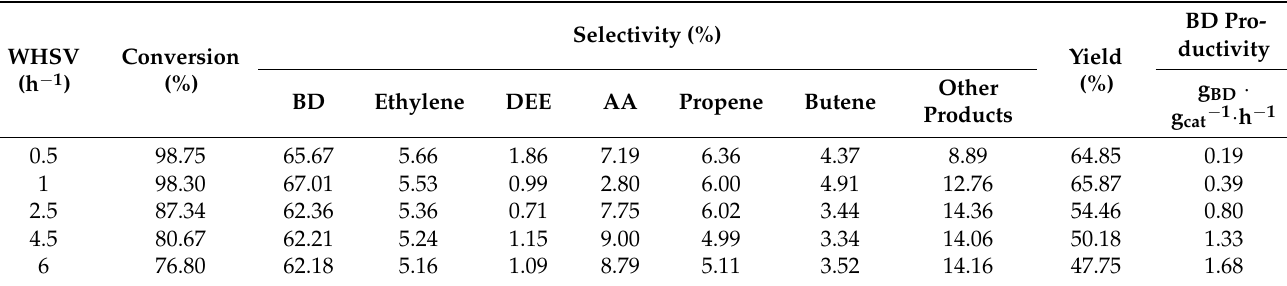
Table 6. Effect of WHSV on catalytic activities over the Cu 1 Zn 2 Y 5 /SiBEA catalyst.